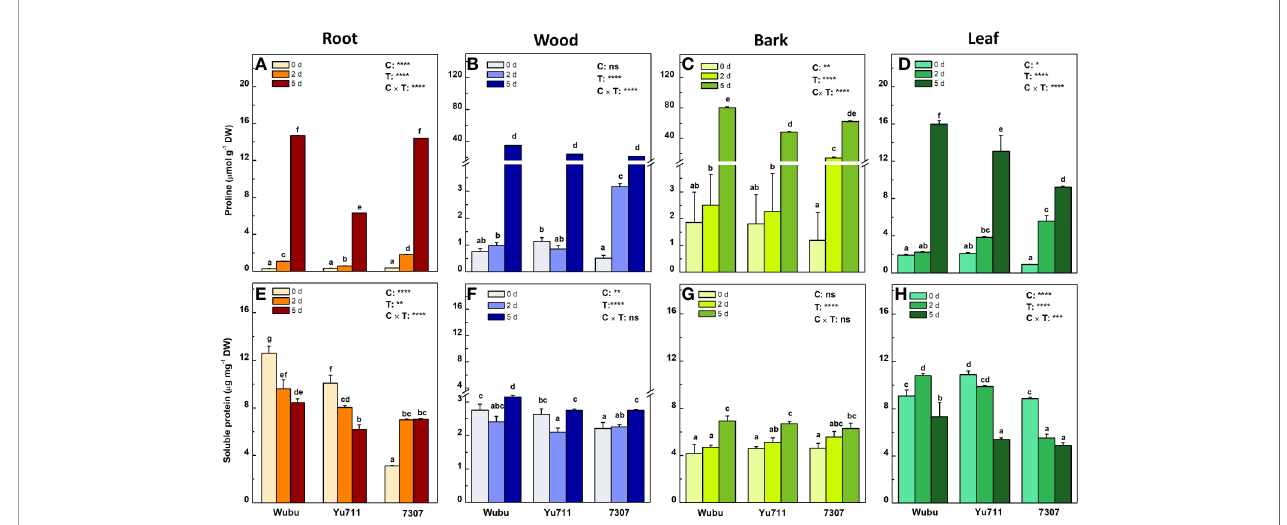
FIGURE 6 | Concentrations of free prolien (A – D) and soluble proteins (E – H) in roots, wood, bark, and leaves of mulberry cultivar Wubu, Yu711, and 7307 exposed to progressive drought stress for 0, 2, and 5 days (denoted as 0 d, 2 d, and 5 d), respectively. The bar indicates mean ± SE (n = 6). Different letters on the bars indicate signi fi cant difference. ANOVAS of cultivars (C), time (T) and their interaction (C × T) are also indicated. * P < 0.05; ** P < 0.01; *** P < 0.001; **** P < 0.0001; ns, not signi fi